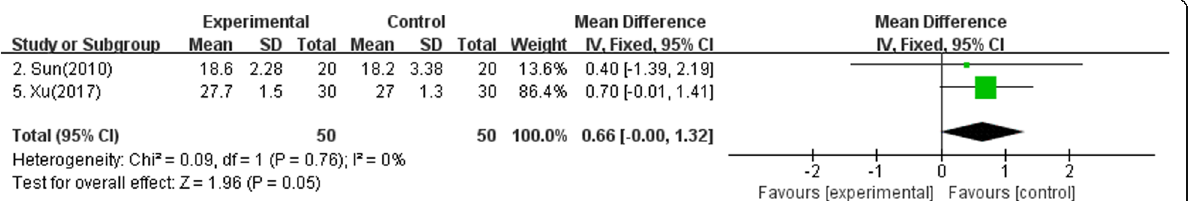
Fig. 5 Meta-analysis of MoCA of studies